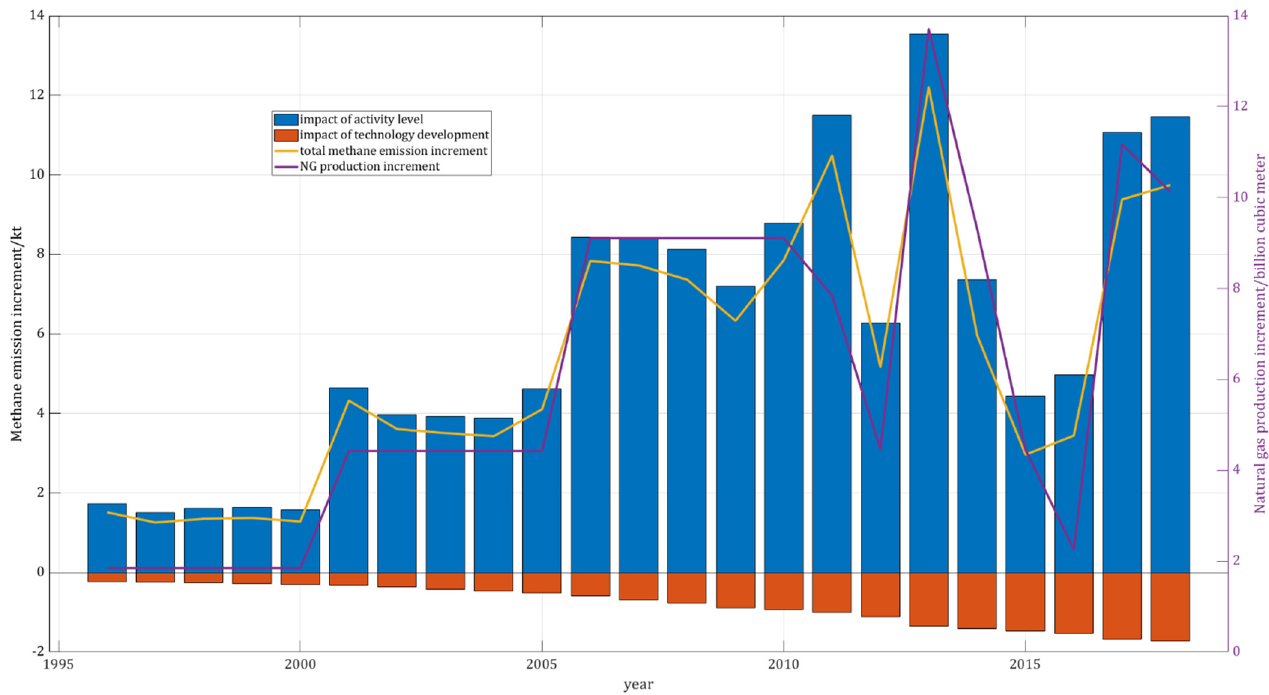
Figure 7. A comparison of the impact of activity level increase and technology development on the total methane emission. Increments of total methane emission and natural gas production are also shown.